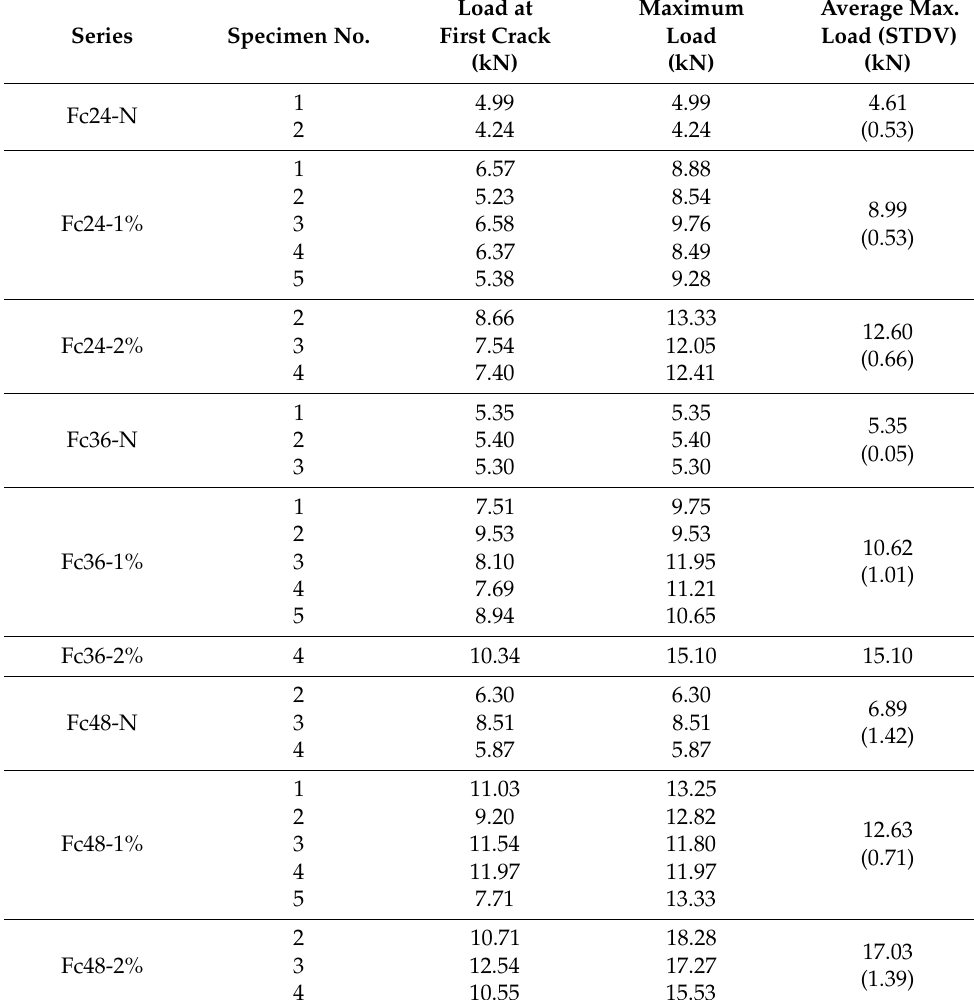
Table 4. Results of uniaxial tension test.